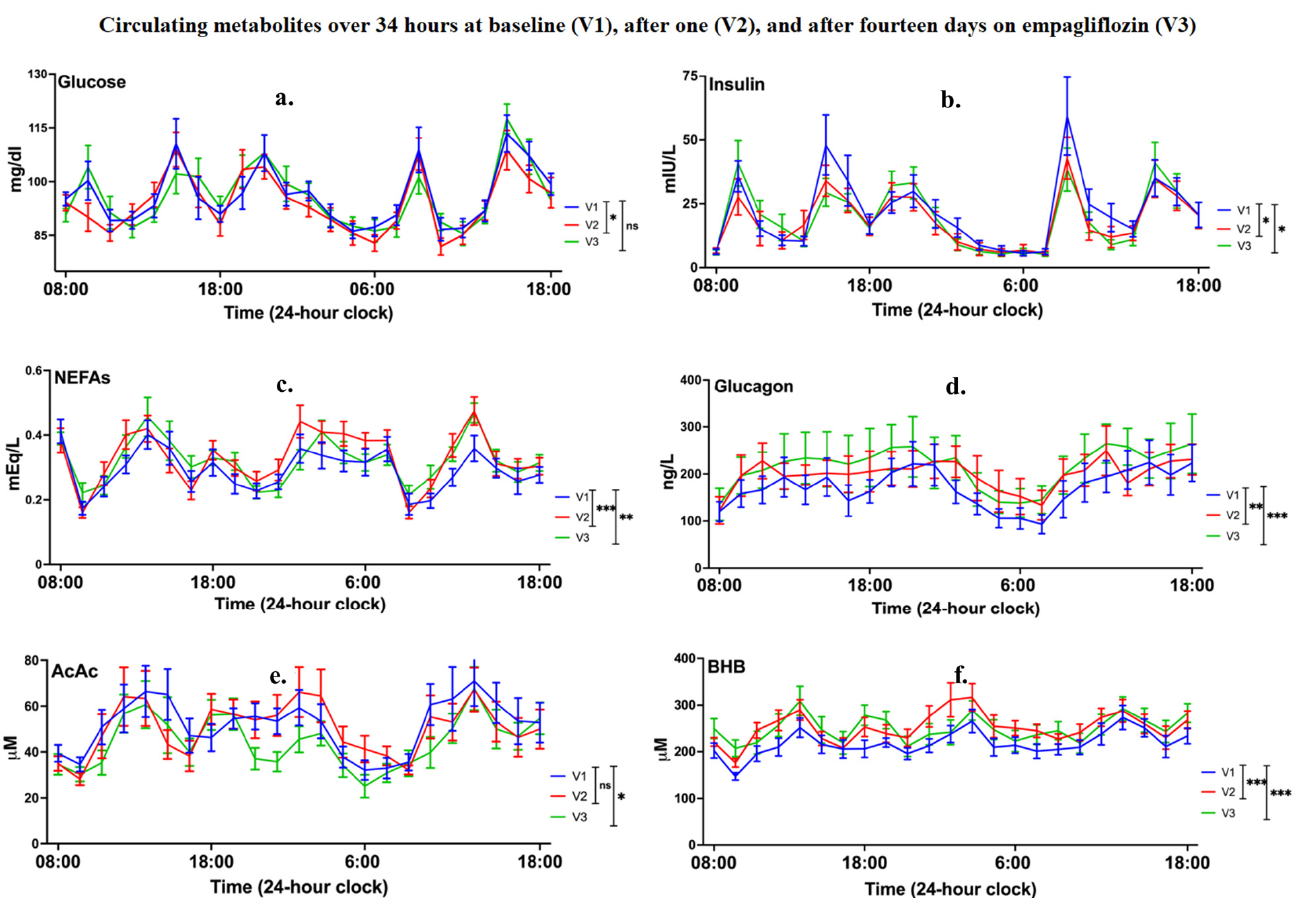
Figure 2. Means (SEs) of circulating metabolites and hormones (( a – f ): glucose, insulin, non-esterified fatty acids (NEFAs), glucagon, acetoacetate (AcAc), β -hydroxybutyrate (BHB)) measured from blood draws over a 34-h window (22 timepoints) starting at 8 am in the morning and finishing at 6 pm the next afternoon (i.e., every 1.5 h × 2, 1 h × 1, 1.5 h × 8, 2 h × 4, 1.5 h × 2, 1 h × 1, and finally 1.5 h × 4), at baseline (visit 1 (V1)), immediately before and after the first empagliflozin dose (visit 2 (V2)), and immediately before and after the last empagliflozin dose (visit 3 (V3)). Statistical analysis involved repeated-measures linear mixed models with “Visit” as the repeated-measures variable and additional variables as factors and covariates (see Section 2.9 for details). Significance is indicated in the graphs when type III tests of fixed effects for “Visit” and pairwise comparisons between “Visits” were significant. Significance symbols ns, *, **, *** correspond to p > 0.05, p ≤ 0.05, p ≤ 0.01 and p ≤ 0.001, respectively. Regarding insulin, the first empagliflozin dose induced a 15% decrease (on average over 34 h) compared with baseline (F 1, 902.122 = 6.530, p = 0.011; MD = − 3.307 mIU/L, 95% CI = − 5.846, − 0.767). The last dose decreased insulin by 12% (on average over 34 h) compared with baseline (F 1, 880.870 = 3.970, p = 0.047; MD = − 2.647 mIU/L; 95% CI = − 5.255, − 0.040). The first empagliflozin dose increased glucagon levels by 12% (on average over 34 h) compared with baseline (F 1, 381 = 7.900, p = 0.005; MD = 19.572 ng/L, 95% CI = 5.880, 33.263). There was an interaction between Visit and Sex (F 1, 381 = 4.542, p = 0.034) showing a signifi- cant elevation in men (F 1, 381 = 27.476, p < 0.001), but not women (F 1, 381 = 0.148, p = 0.700). Similarly, the last dose increased glucagon by 16% (on average over 34 h) compared with baseline (F 1, 374.045 = 10.636, p = 0.001; MD = 25.416 ng/L; 95% CI = 10.092, 40.741). An interaction between Visit and Sex was also found after the last dose (F 1, 374.045 = 14.925, p < 0.001), showing that glucagon increased in men (F 1, 374 = 61.711, p < 0.001), but did not change in women (F 1, 374 = 0.114, p =